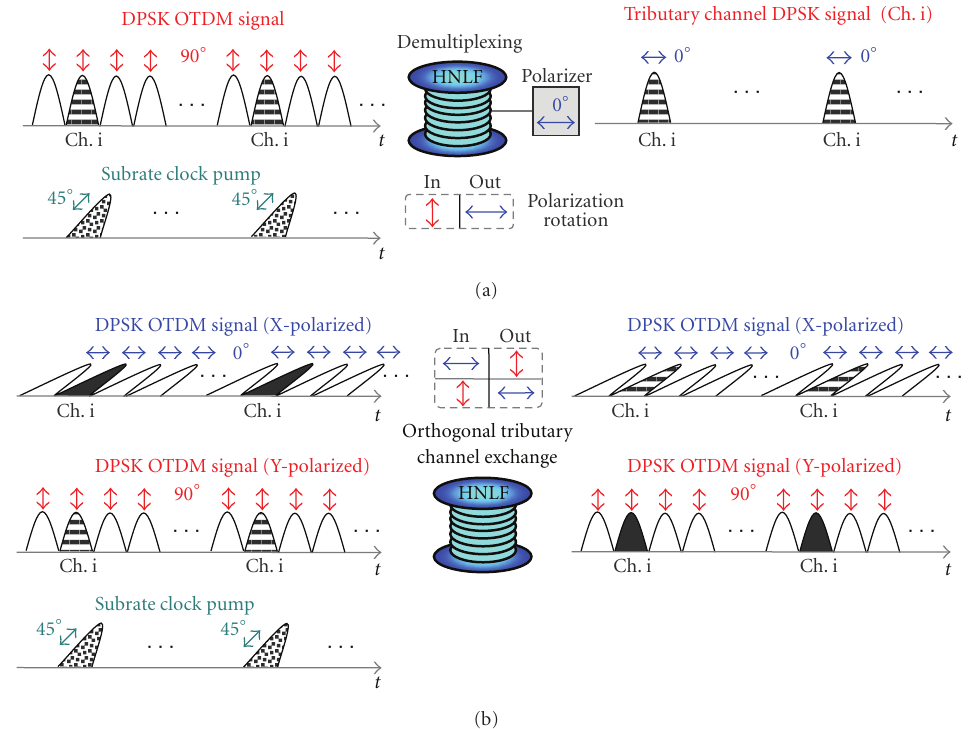
Figure 29: Concept and principle of Kerr e ff ect-based (a) DPSK OTDM signal demultiplexing and (b) orthogonal tributary channel exchange of a pol-muxed DPSK OTDM signal.